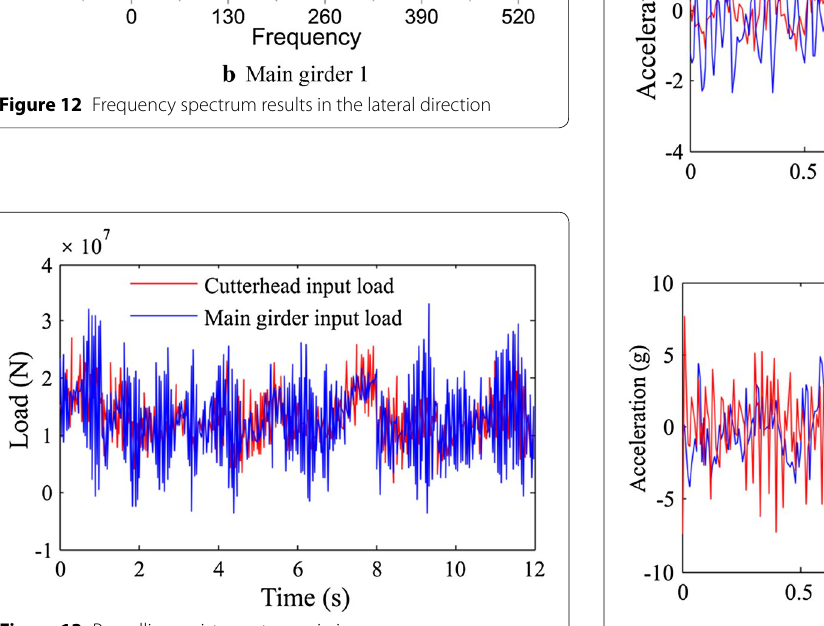
Figure 13 Propelling resistance transmission Figure 15 Measured and calculated accelerations of acceleration are lower than the calculated values, which mainly range between 2.3 g and 2.3 g with the maxi- − Comparison of the field-test and calculated values of mum value reaching 5 g . Mean-square deviation of the the acceleration in the TBM mainframe reveals that the measured tunneling acceleration is 1.51 g , and that of calculated values of the lateral and vertical vibration the calculated acceleration is 1.72 g .